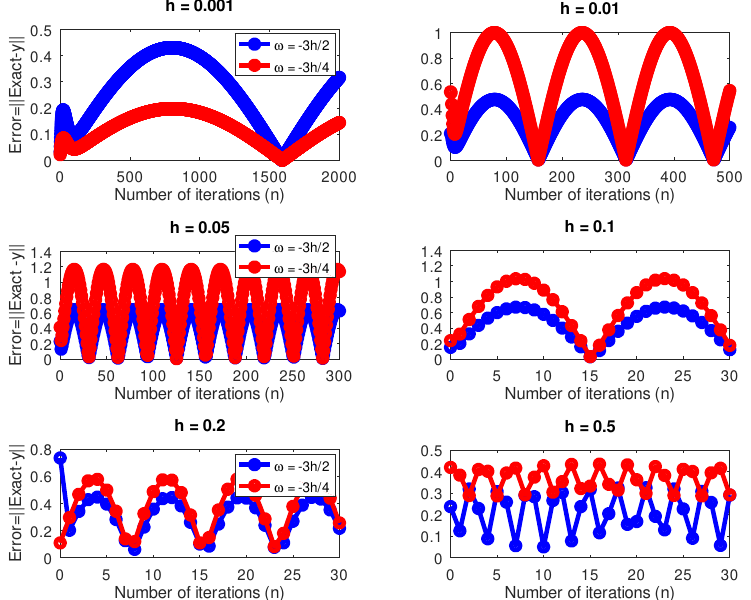
3 h and the discrete schemes (7)–(10) corresponding to ω = 3 h 4 and the discrete schemes (7)–(10) corresponding to ω = − 4 −